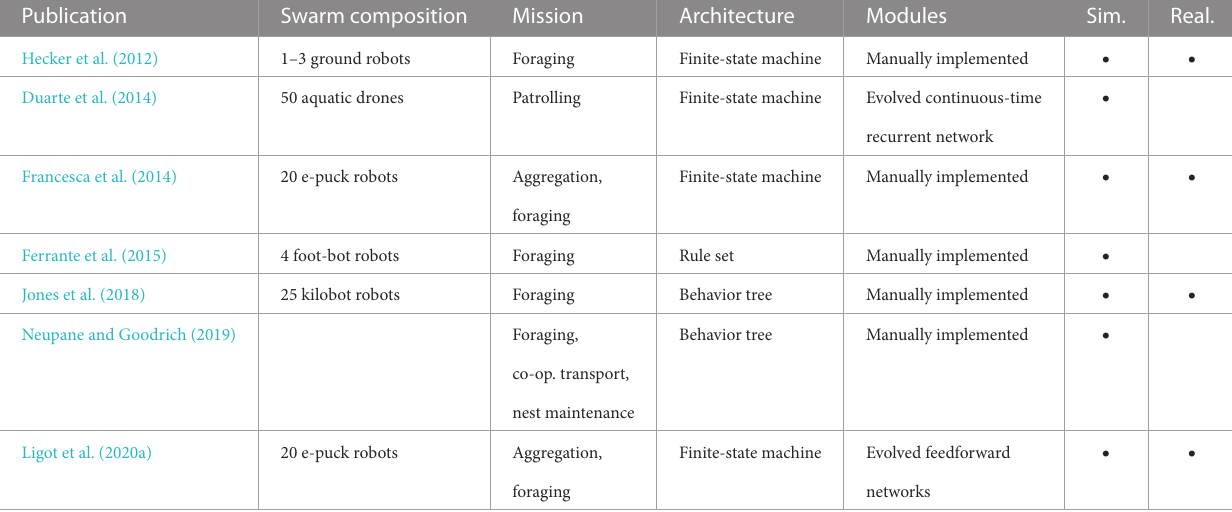
TABLE2 Overviewofselectedautomaticmodulardesignresearchinswarmrobotics.